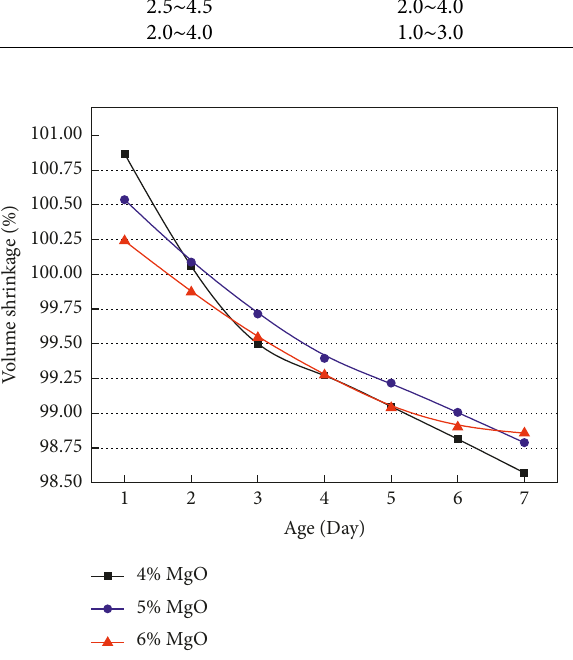
Figure 10: Volume shrinkage rate of MOC solidified soil with different